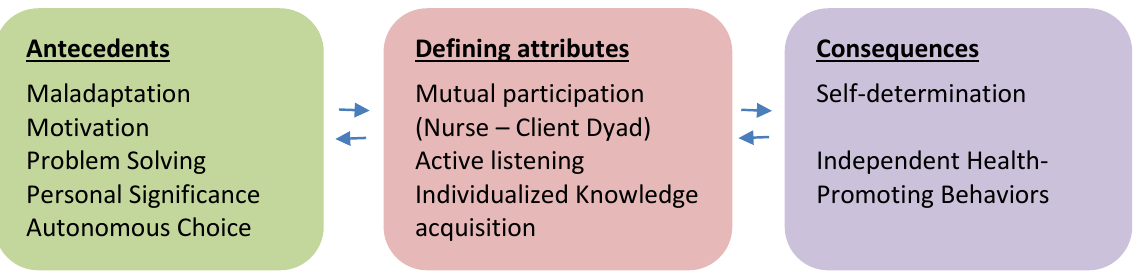
Figure 1. Ellis-Stoll and Popkess-Vawter’s model of the empowerment process.